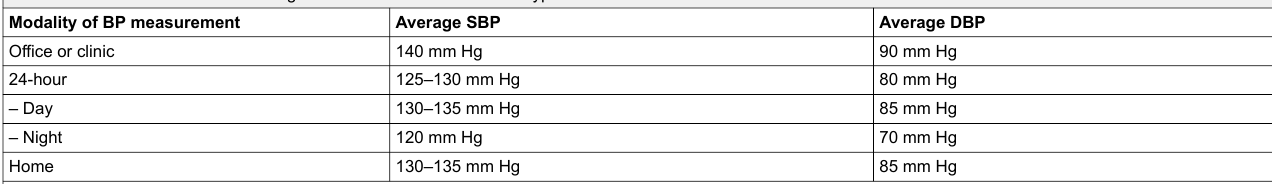
Table 1: Reference values for the diagnosis and exclusion of arterial hypertension.